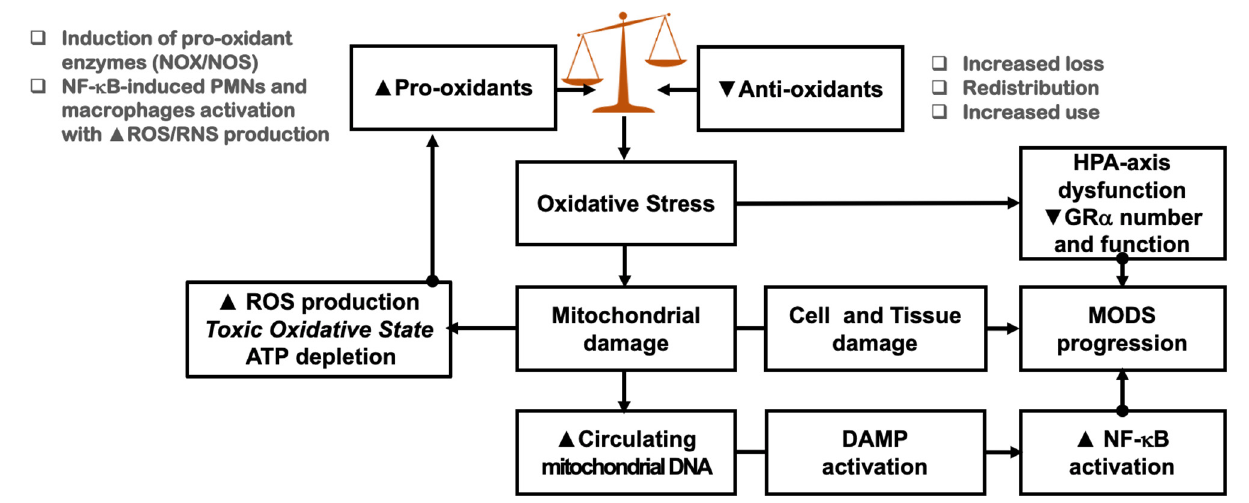
FIGURE 5 | Impact of oxidative stress on homeostatic corrections. See sections Mitochondrial Cacostatic Load, Oxidative Stress, and Mitochondrial Damage, Mitochondria and HPA-Axis Cross-Talk, and Oxidative Stress and CIRCI for explanation. PMN, polymorphonuclear cells; MODS, multiple organ dysfunction syndrome.